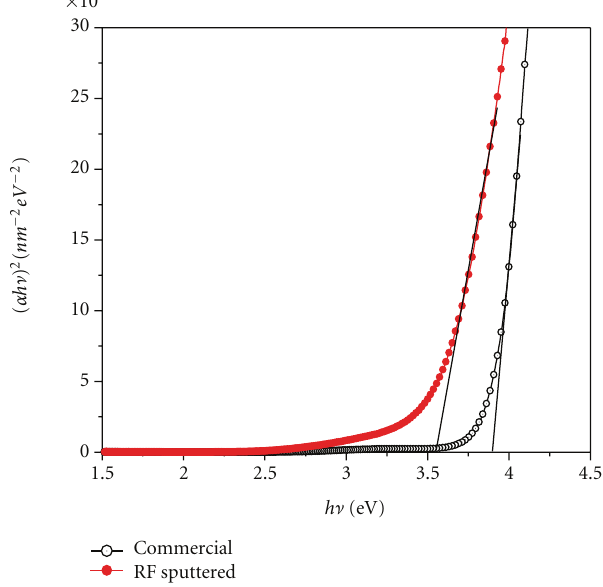
Figure 7: ( αh ν ) 2 versus h ν plots for commercial and RF-sputtered ITO thin